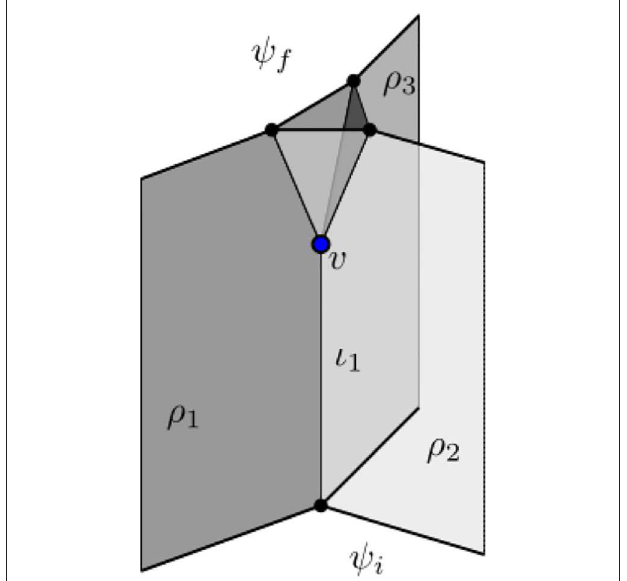
FIGURE 2 | A spin foam in 3D with boundary. The boundary of this spin foam is made up of an initial and a final graph, which carry states ψ i and ψ f , respectively. The links of a graph carry representations ρ f , whereas the nodes carry intertwiners ι e . For ψ i , these are ρ i , i = 1,2,3, and ι 1 . The data for ψ f is omitted for clarity of the figure. The 2-complex interpolates between these two graphs and evolves the states. Thus, in the 2-complex, representations are associated with faces and intertwiners with edges. Several edges meet at a vertex v , here shown in blue. The vertex shown here is dual to a 3D tetrahedron: four edges, each dual to a triangle, are glued together to form a